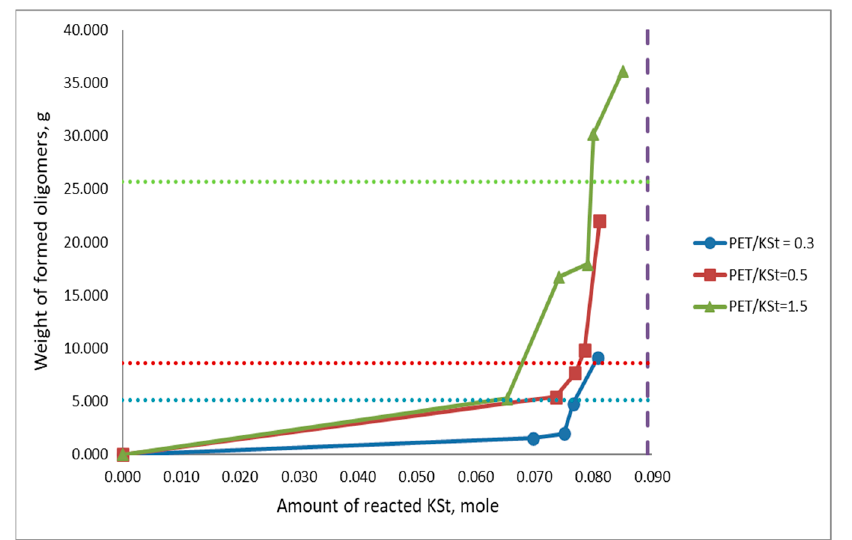
Figure 2. The precipitate formation in ethylene glycol for different initial molar ratios PET/KSt at 190 ° С . Horizontal lines are total amounts of PET; vertical line is total amount of KSt.